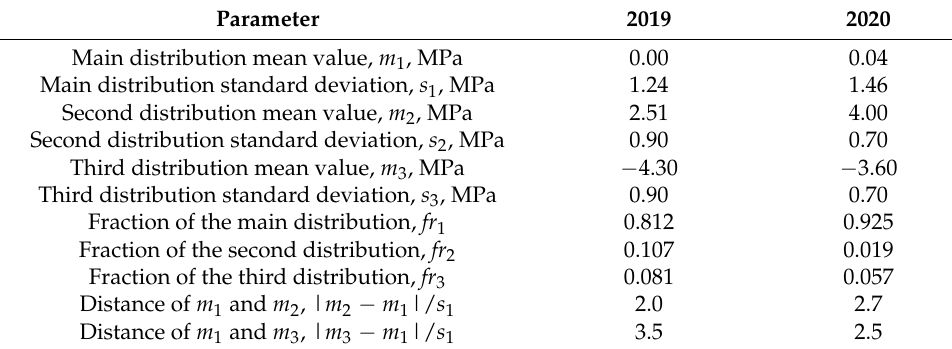
Table 1. Parameters of the normal